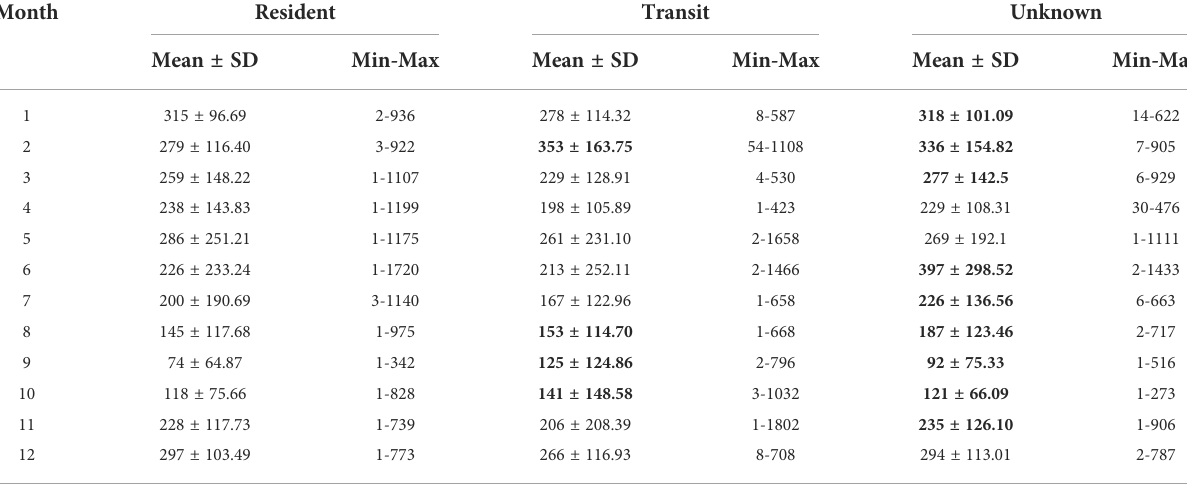
TABLE 2 Bathymetric data (m) associated with HSSSM predicted locations of bowhead whales by behavioural state (resident, transit and unknown) and month. Month Resident